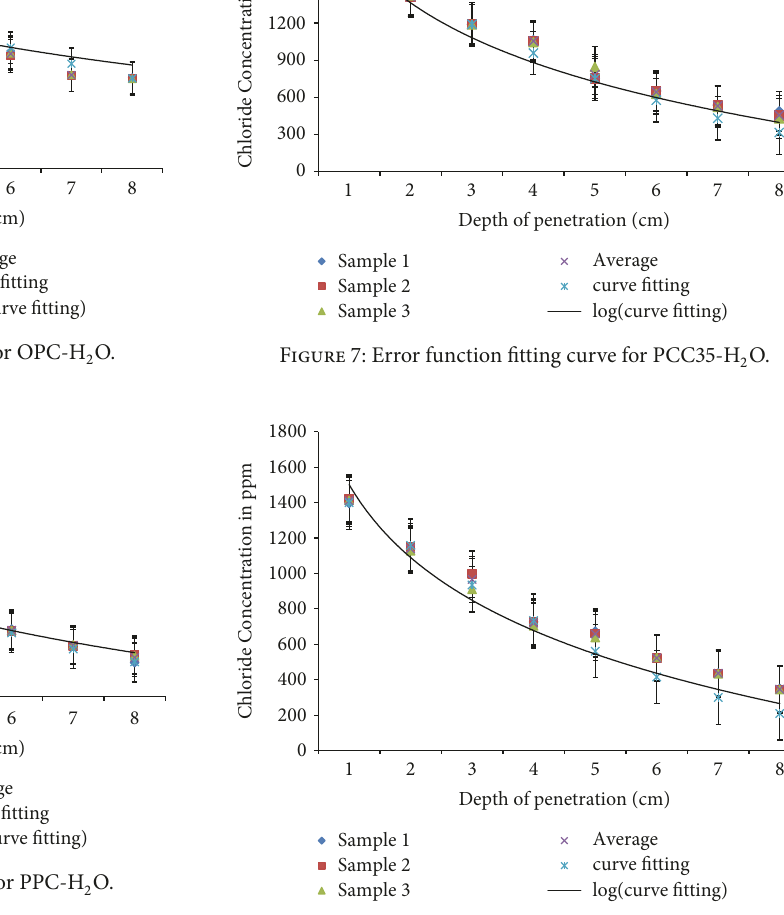
Figure 8: Error function fitting curve for PCC35-0.5M Na 2 SO 4